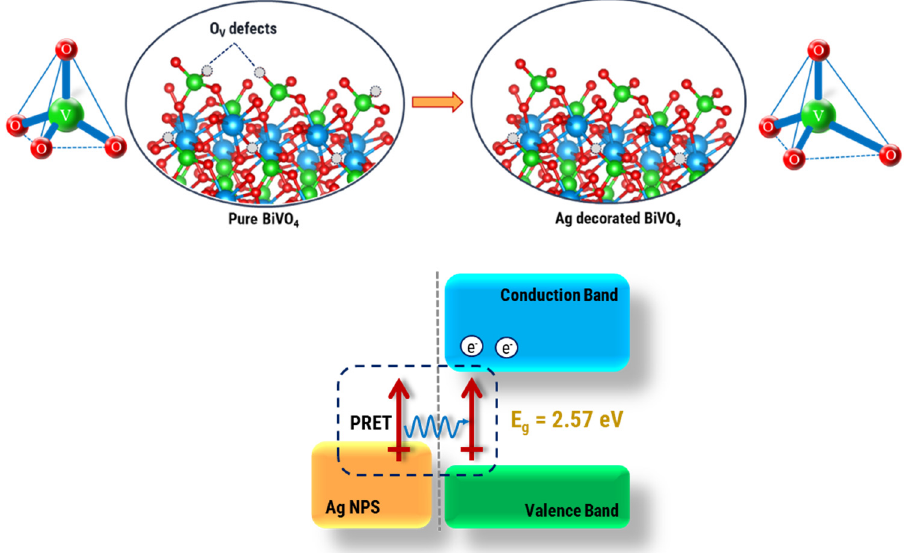
Figure 8. Schematic representative results concerning the effect of Ag NPs decorated on BiVO 4.